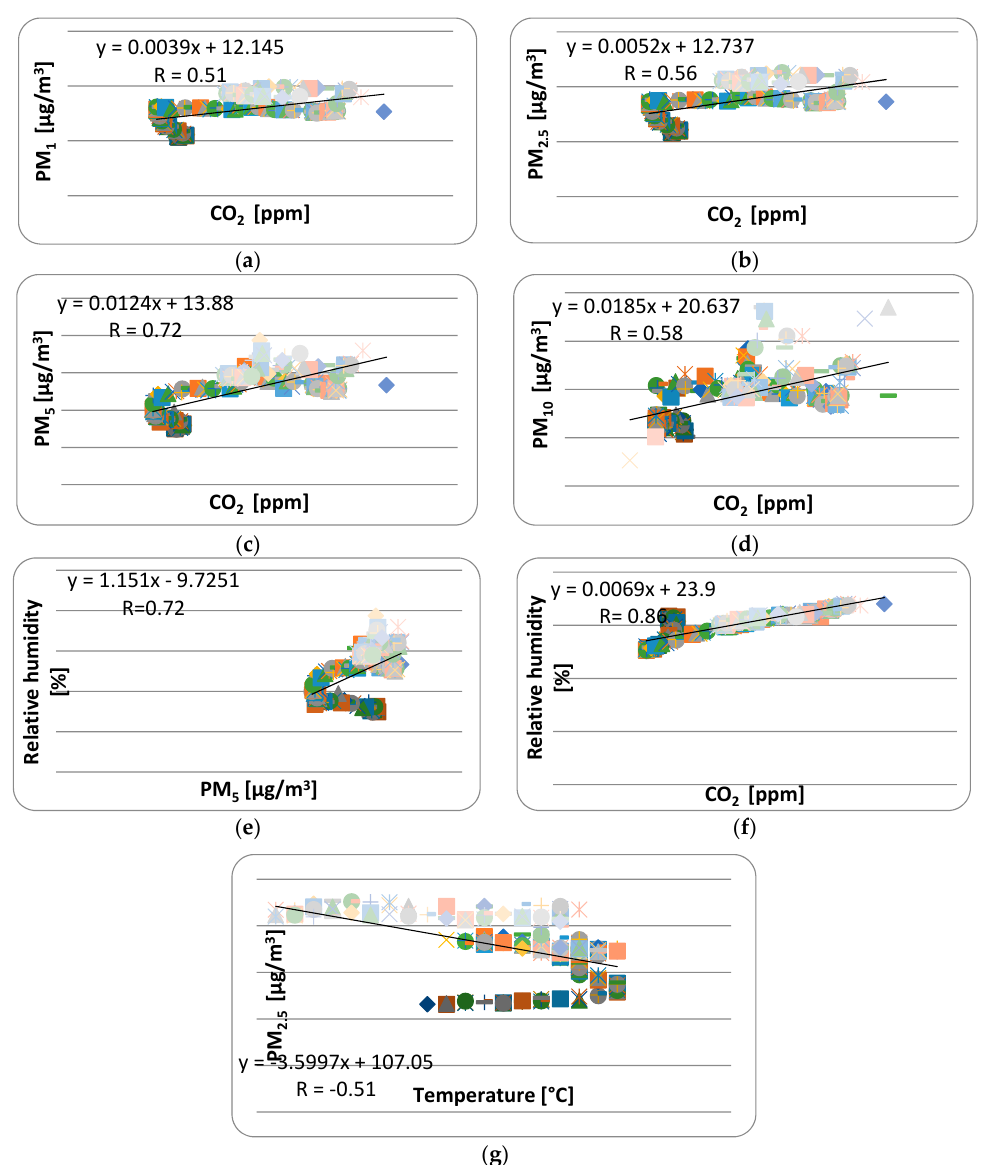
Figure 11. Correlations between environmental parameters. ( a ) Correlation between CO 2 and PM 1 ; ( b ) Correlation between CO 2 and PM 2.5 ; ( c ) Correlation between CO 2 and PM 5 ; ( d ) Correlation between CO 2 and PM 10 ; ( e ) Correlation between PM 5 and RH; ( f ) Correlation between CO 2 and RH; ( g ) Correlation between temperature and PM 2.5 .